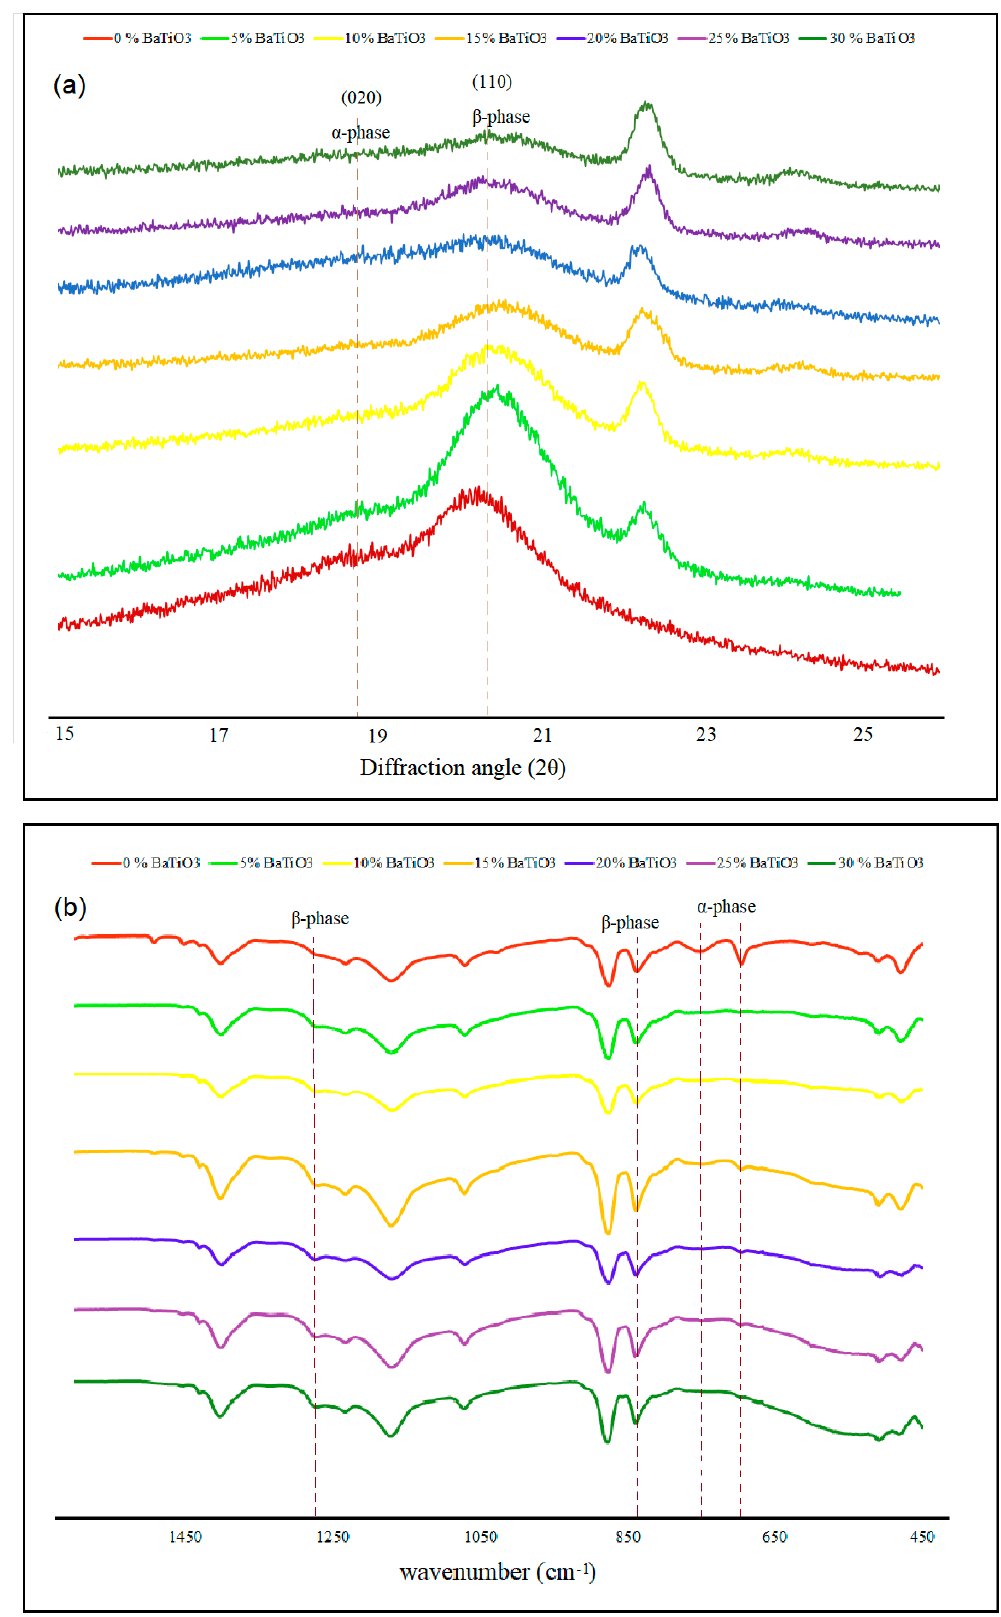
ff erent BaTiO 3